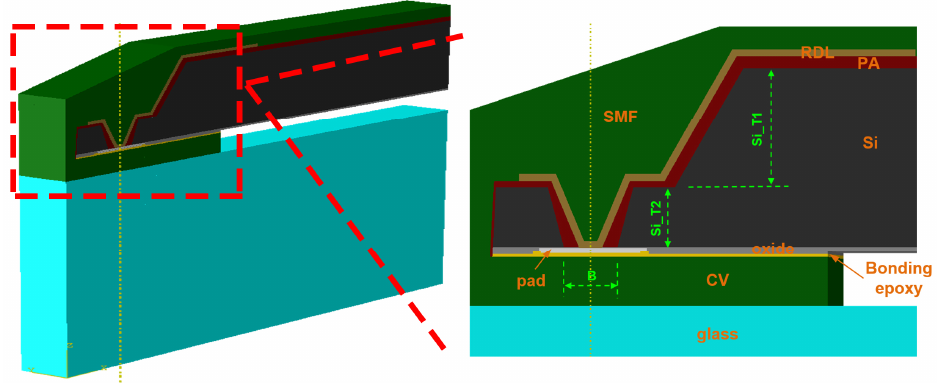
Figure 5. The strip model of the WLSCP in ABAQUS.